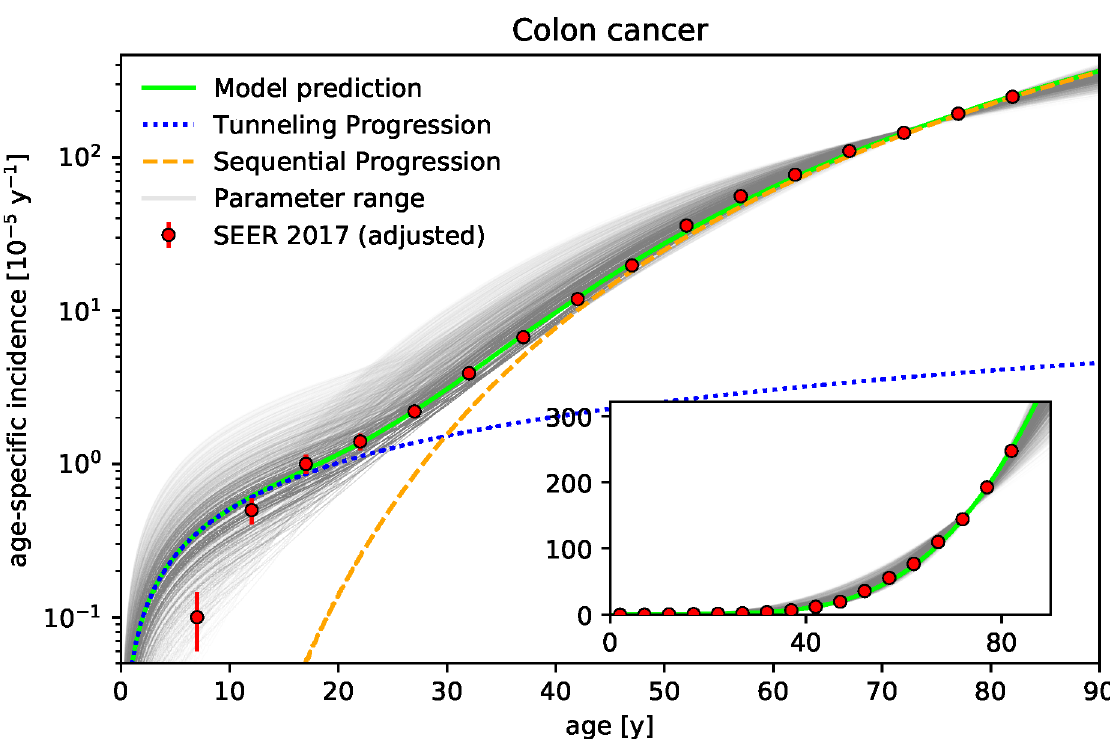
Fig 1. Niche competition in colonic crypts models age-specific incidence rates of colon cancer. Age-specific incidence rates of colon cancer predicted by the model (green and gray lines) agree with epidemiological data (red dots, SEER database [33] adjusted for effects of colorectal screening at > 55 years, see Sec C in S1 Text, error bars correspond to 95% confidence interval assuming Poisson distribution and are often smaller than symbol size) over several orders of magnitude (see inset for linear y-scale). For the model prediction the range of the parameters niche size N , number of crypts K , mutation probabilities u , v , and probability γ of adenoma progressing to adenocarcinoma are taken from the literature, see Table 1, while the time scale set by the effective replacement rate λ is calibrated based on the epidemiological data. Sensitivity on parameters is illustrated by variation of the parameters within the reported ranges (gray lines, opacity scaled inversely with corresponding goodness-of-fit * 1/ χ 2 for clarity). Exemplary parameter set with N = 8, K = 2 � 10 7 , u = 7.13 � 10 − 6 , v = 1.75 � 10 − 6 , and γ = 9.4% is highlighted in green. Decomposition of incidence rates predicted by the model into incidences with and without precancerous lesions (sequential and tunneling progression, orange dashed and dotted blue line respectively for the exemplary parameter set) confirms different origins of cancer at young and older ages. The effective replacement rate λ is found to be considerably smaller than the actual replacement rates ( λ = 0.016 y − 1 per stem cell for the green curve and λ = 0.024 ± 0.01 y − 1 for the gray curves).